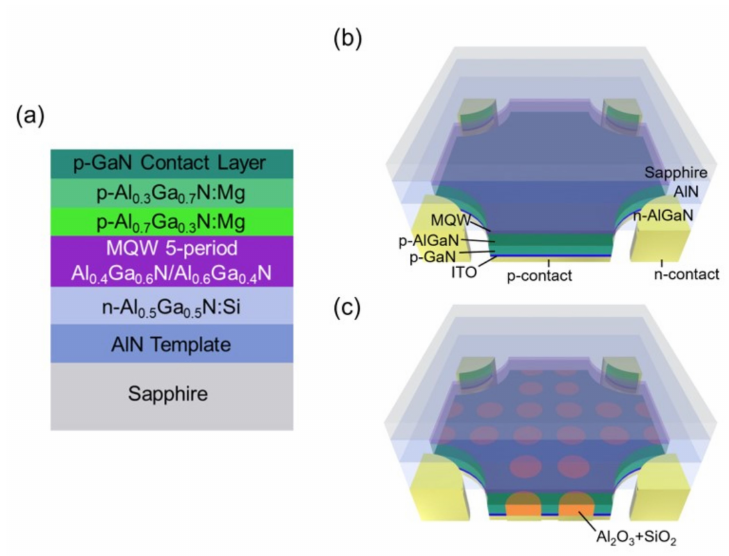
Figure 1. ( a ) The schematic epi-structure of based-DUV LEDs- Deep Ultraviolet. ( b ) The schematics of the conventional DUV LED. ( c ) The schematics of the mesh p-GaN / ITO DUV LED within four